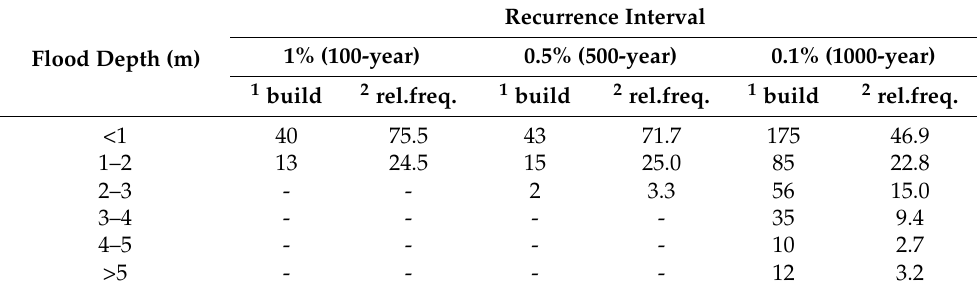
Table 7. Number of buildings with a high potential to be affected and the flood wave depth computed for eachdam breakscenarios with1% (100-year), 0.5% (500-year), and 0.1% (1000-year) recurrence intervals.